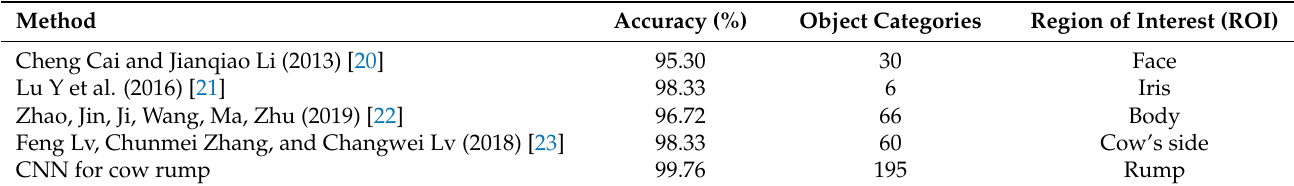
Table 3. Identification accuracy comparison of cow rump and other related